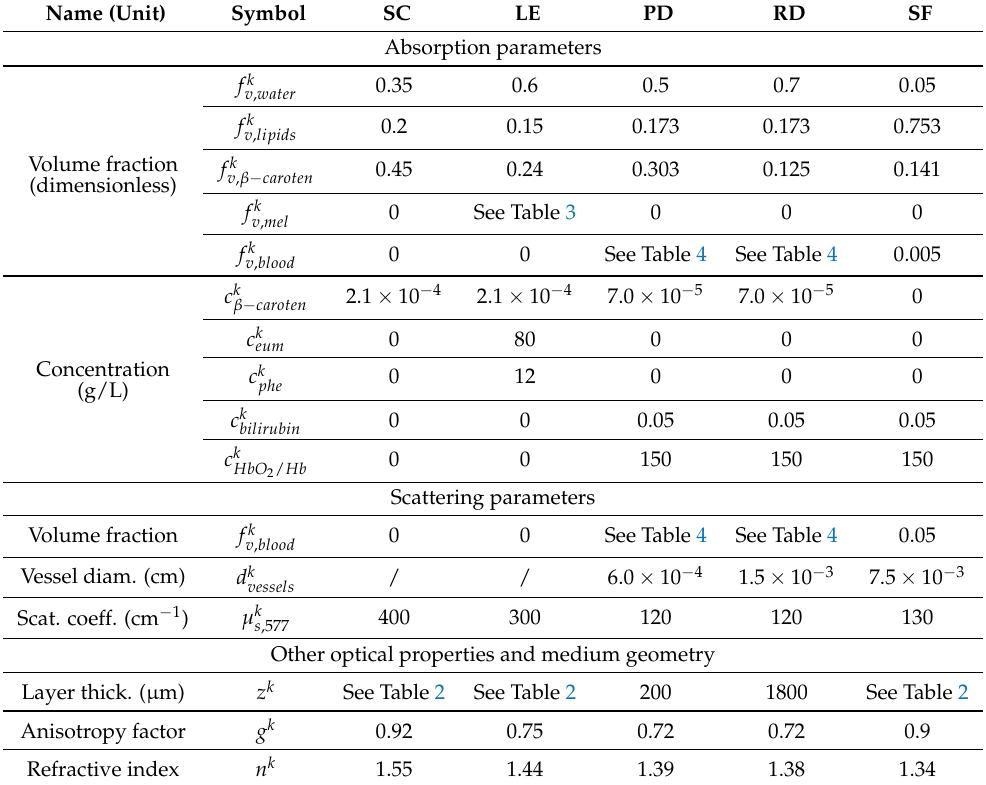
Table 5. Values of the geometrical and optical parameters of our five layer skin model. SC, LE and SF thickness ranges, f k melanosome fraction range in LE and f k v , mel refer to Tables 2–4,